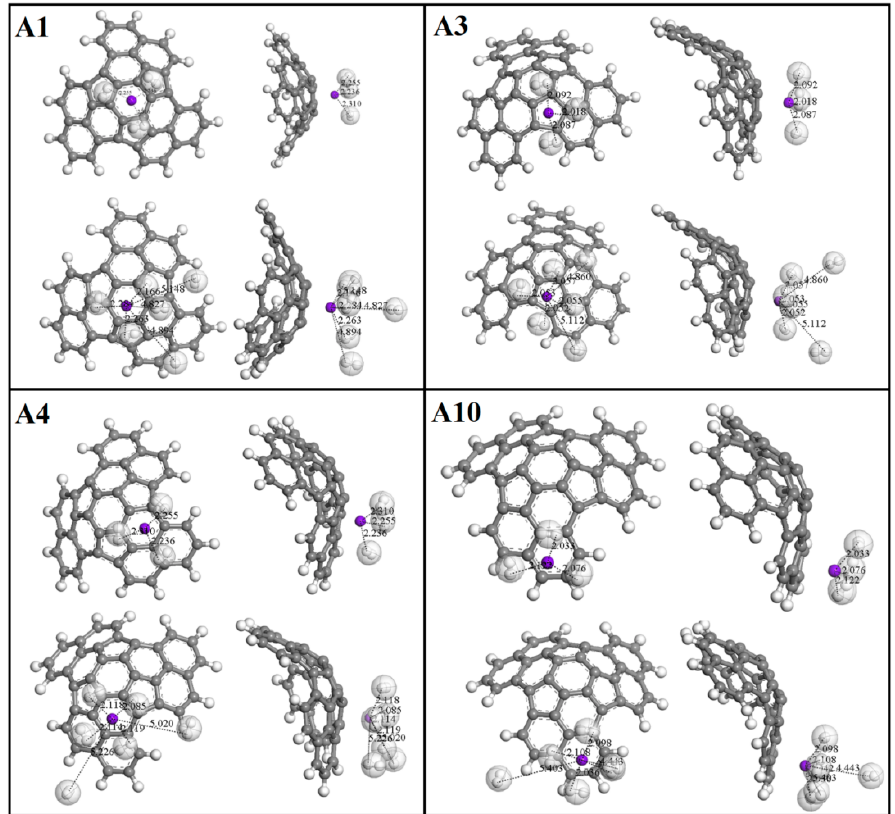
Figure 4. Adsorption configurations of three (above panels) and six (below panels) H 2 molecules on A1, A3, A4, A10 sites respectively in Sc-doped-ZTC (Sc-C 39 H 15 ). The top and side views are respectively shown by the left and right parts in each schematic unit, and the gray, white and violet balls identify carbon, hydrogen and scandium atoms respectively.